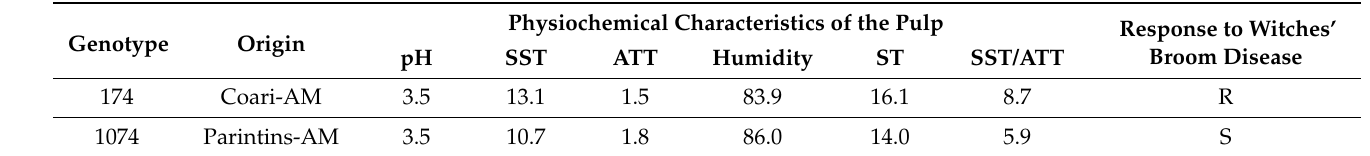
Table 1. Cupuassu plant material characteristics. AM: Amazonas; ATT: titratable acidity; R: resistant; S: susceptible; SST: total soluble solids; and ST: total